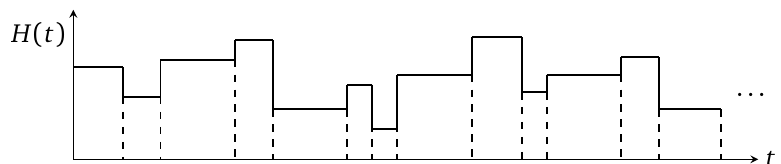
Figure 1: Schematic illustration of a random driving with randomly chosen driv- ing Hamiltonians and random time durations. Here we consider the one parameter family of driving Hamiltonians, and the y axis corresponds to the values of this pa-